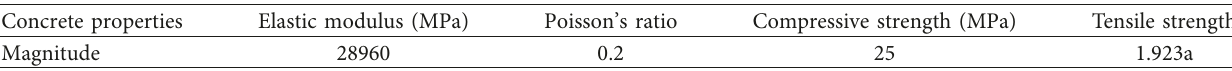
Table 2: Concrete properties [16].